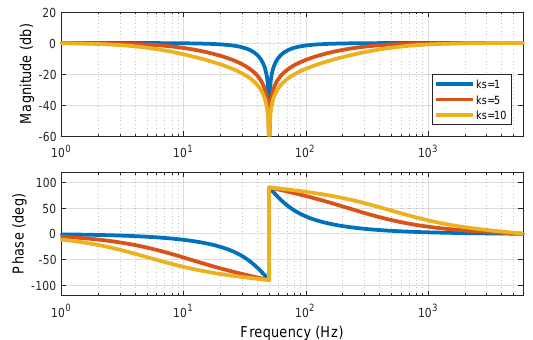
Figure 7. Frequency response of G BSF ( z ) with different values of k s